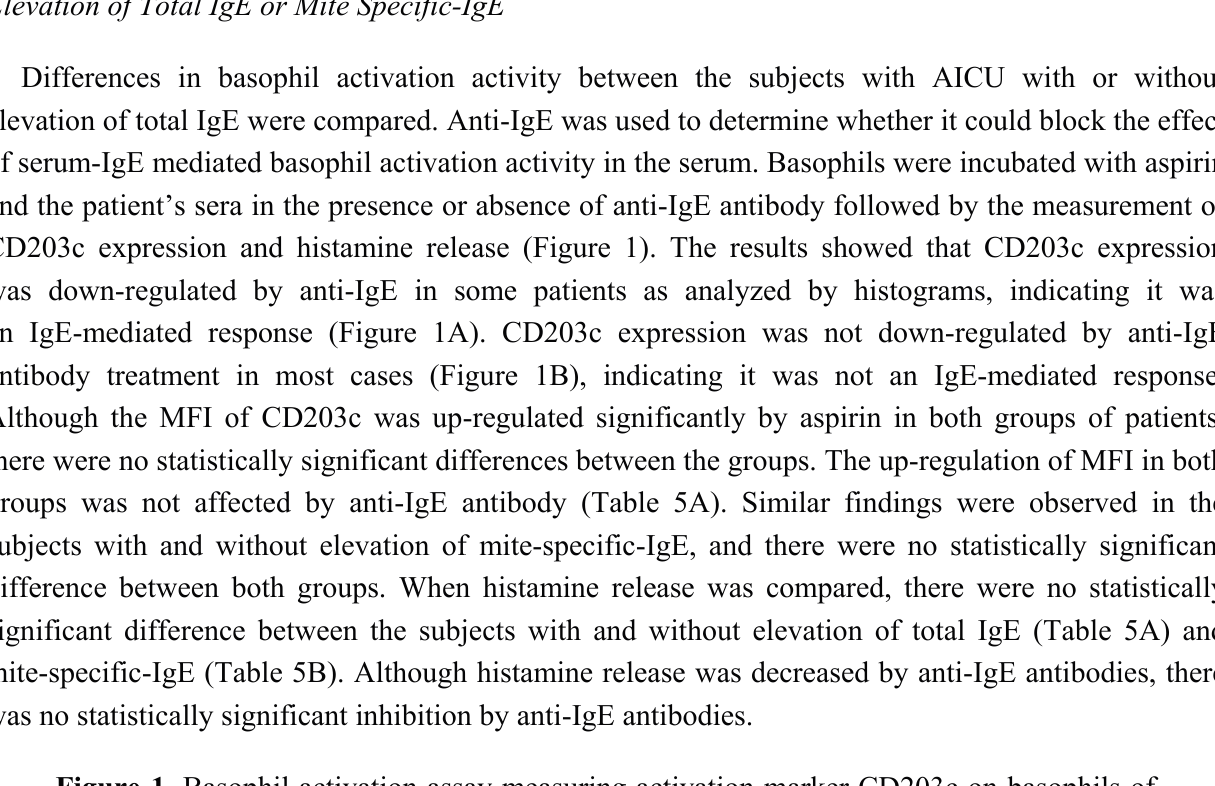
Figure 1. Basophil activation assay measuring activation marker CD203c on basophils of patients AICU with IgE-mediated response ( A ) AICU without IgE-mediated response ( B ) and normal healthy controls ( C ). Flow cytometric quantification of de-granulated basophils on cell surface marker CD203c. Data presented as mean fluorescence intensity of CD203c of three